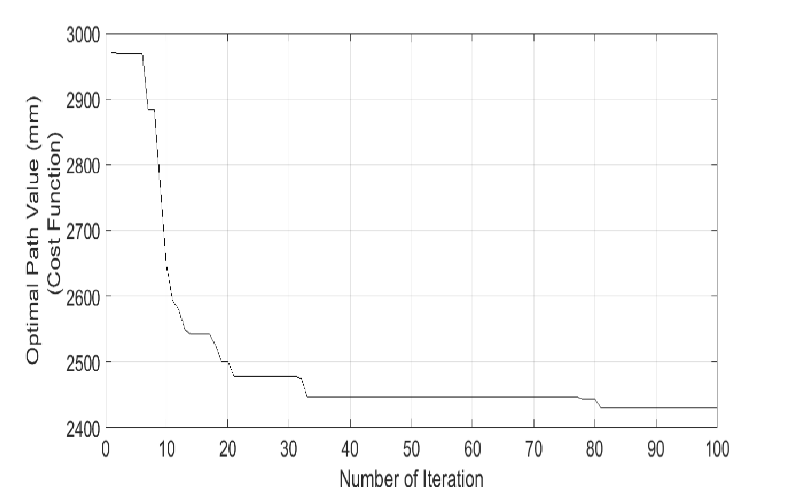
Fig. 11. Best Distance function Founded by GWO Algorithm for Case